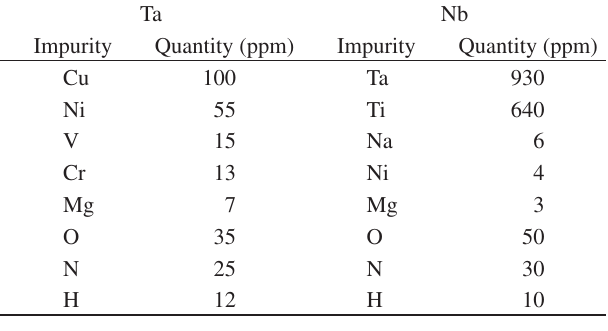
Table 1. Chemical composition of Nb and Ta samples.